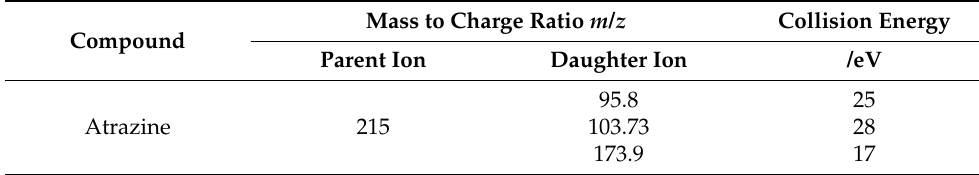
Table 1. MRM method parameters of